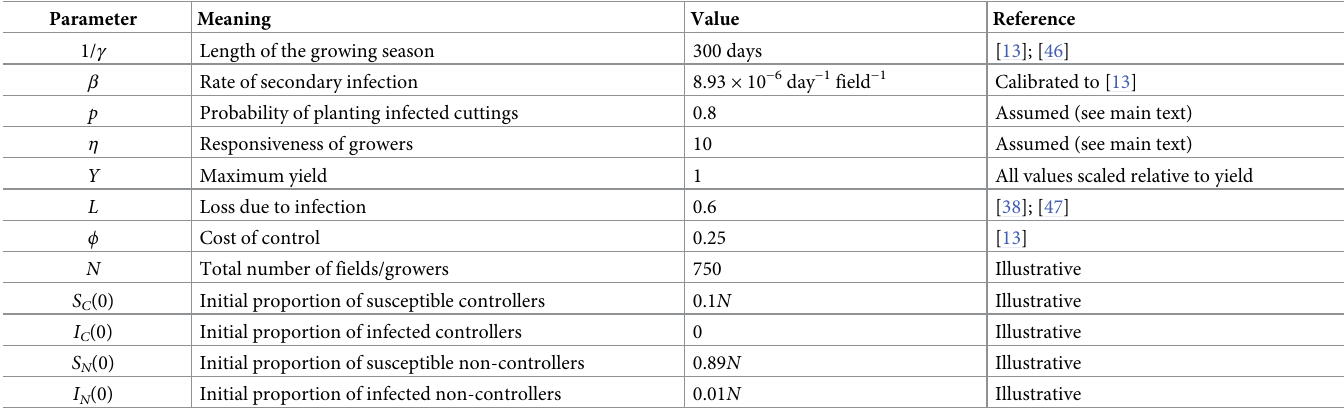
Table 1. Summary of parameter